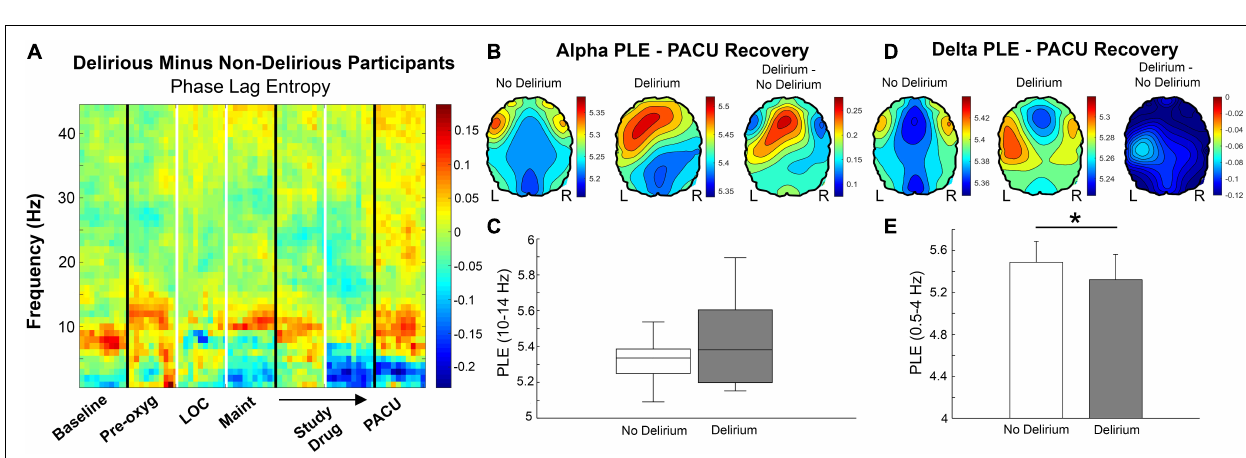
FIGURE 5 | (A) Phase lag entropy presented for non-delirious participants ( n = 42) subtracted from delirious ( n = 11) participants bandwidths and study epochs. High alpha (10 – 14 Hz) phase lag entropy appears increased during delirium in the PACU based on spectral comparisons (red shading). Conversely, delta (0.5 – 4 Hz) phase lag entropy appears lower with PACU delirium (blue shading). Color bars represent median phase lag entropy differences between groups. (B) Alpha phase lag entropy appears increased in anterior regions during delirium. Color bars represent phase lag entropy for the left and middle panels and median difference between groups in the right panel. (C) Although high alpha phase lag entropy was higher in patients with delirium, this increase did not reach statistical significance [5.38 (5.20 – 5.60) vs. 5.34 (5.25 – 5.39); p = 0.258]. (D) Delta phase lag entropy appeared globally reduced during delirium. Color bars represent median phase lag entropy for the left and middle panels and median difference between groups in the right panel. (E) Global delta phase lag entropy was significantly reduced from non-delirious to delirious participants (5.49 ± 0.200 vs. 5.32 ± 0.243, respectively; p = 0.023). Pre-oxy, pre-oxygenation; LOC, loss of consciousness;